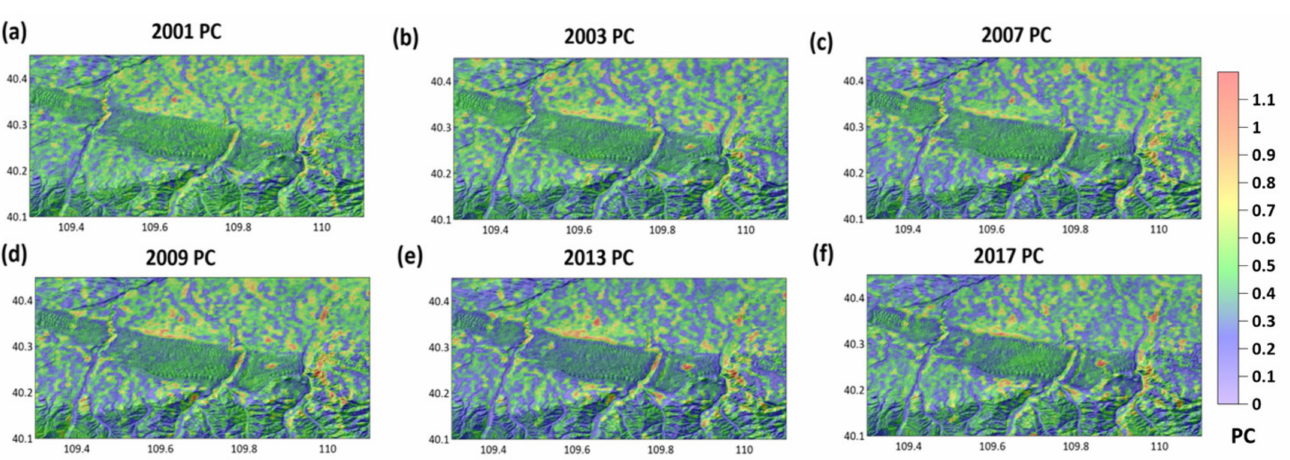
Figure 9. Time-series representations of protrusion coefficients (PCs) in 2001 ( a ), 2003 ( b ), 2007 ( c ), 2009 ( d ), 2013 ( e ), and 2017 ( f ) using MODIS BRDF MOD 42 products (the resolution is 500 m/pixel).